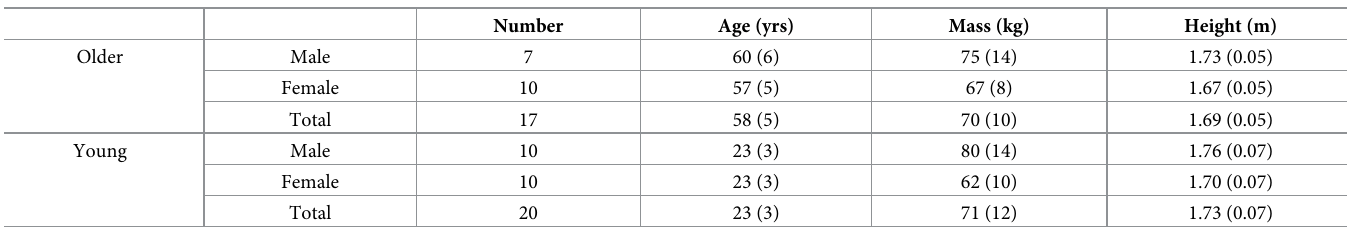
Table 1. Mean (standard deviation) of study